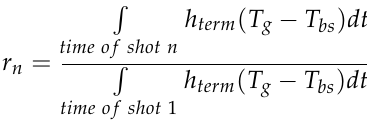
Figure 15. Shape of rotating band with projectile body threshold.